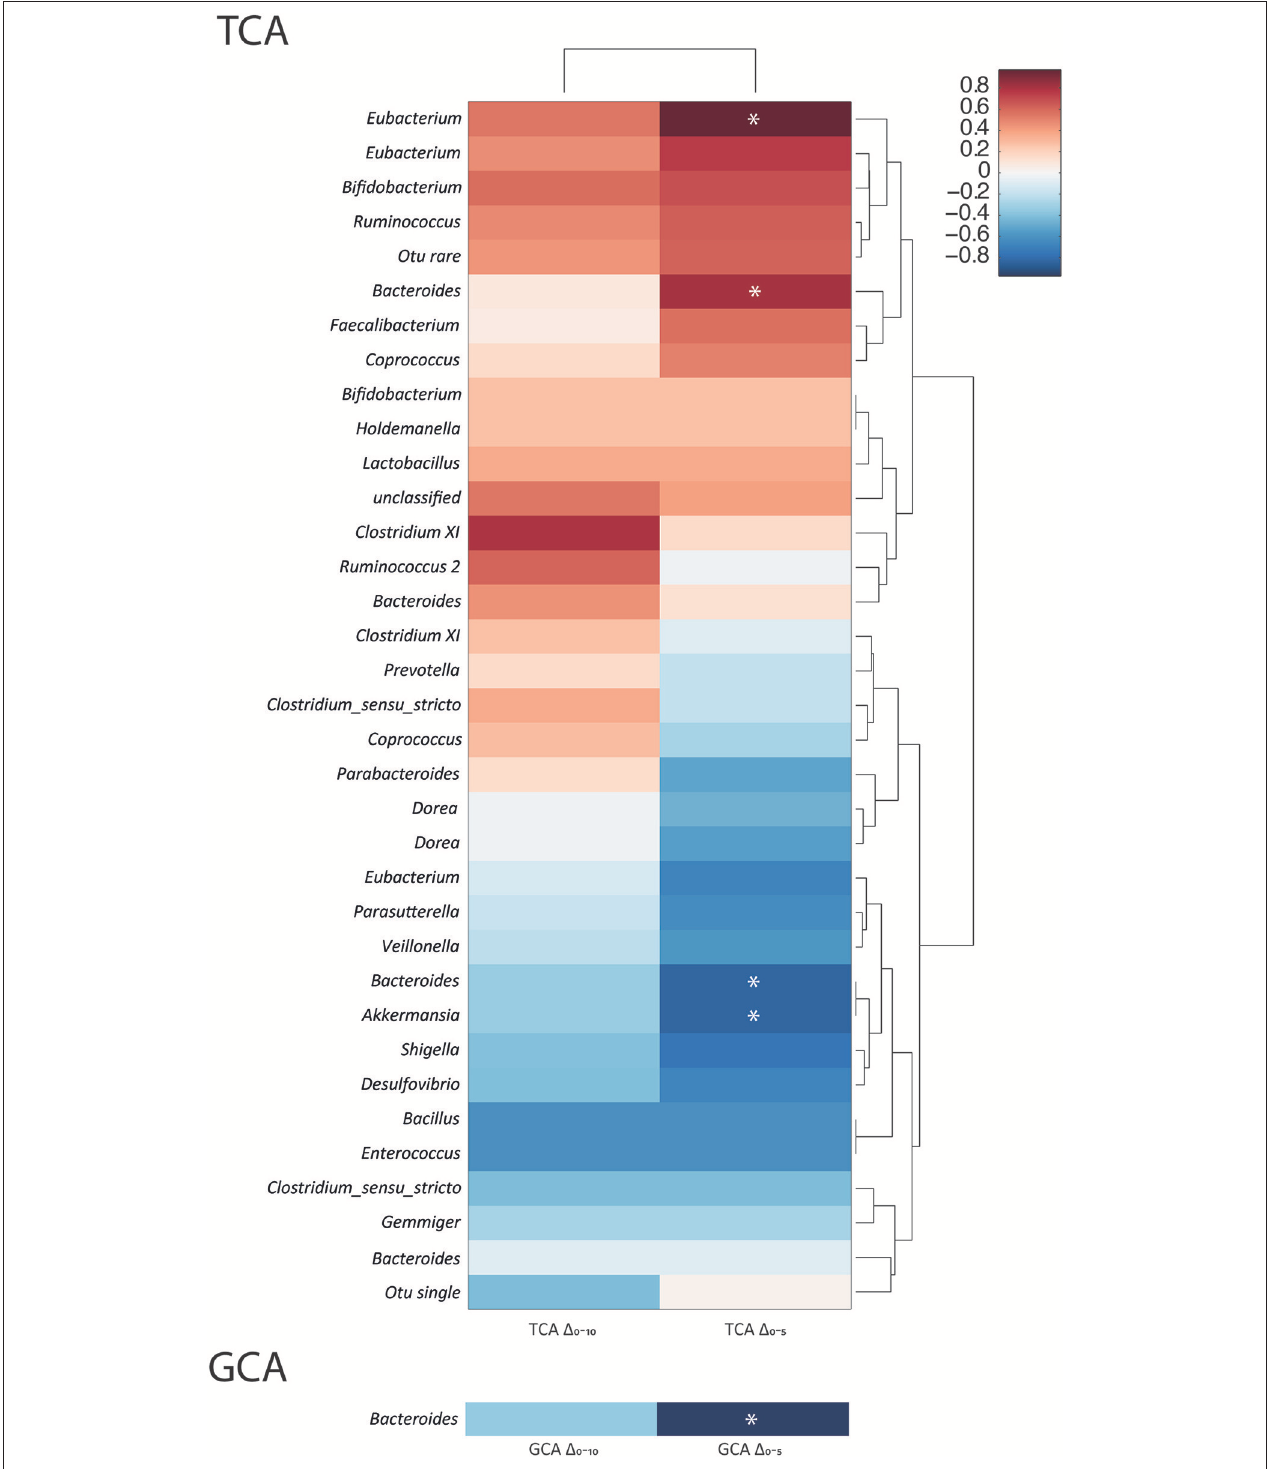
FIGURE 5 | Taurocholic acid deconjugation velocity is positively associated with the Eubacterium and Bacteroides genera. Correlation coefficients between the bacterial genera present in the batch cultures at baseline and the change in TCA concentrations from 0 to 5h ( 1 TCA T5 ) and 0 to 10h ( 1 TCA T10 ) and GCA concentrations from 0 to 5h ( 1 GCA T5 ) and 0 to 10h ( 1 GCA T10 ). Data presented as heat maps with dendograms indicating relatedness between variables. *Significant correlations ( p < 0.05).